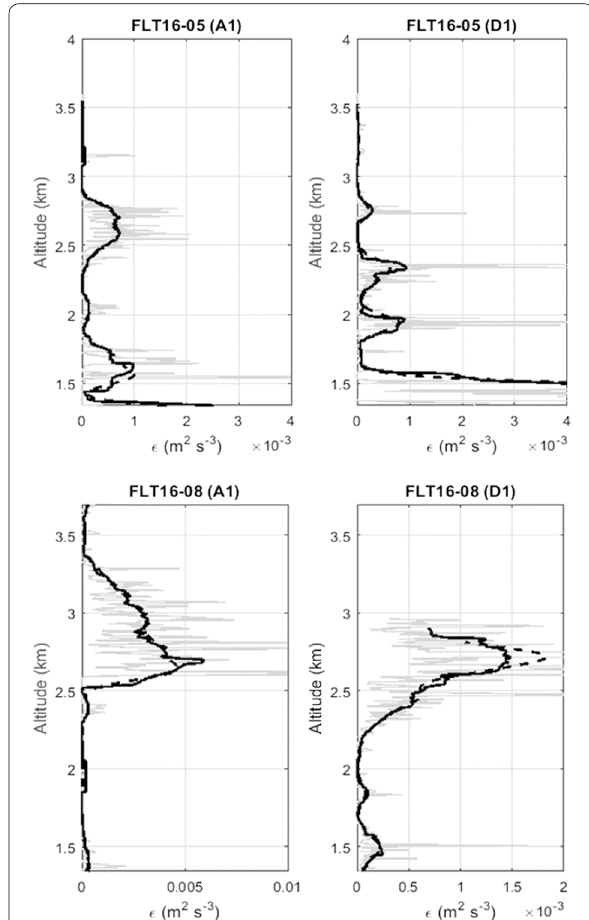
Fig. 6 Examples of the profiles of ε U for the first 2 ShUREX 2016 science flights (FLT16-05 and FLT16-08) during ascent (A1) and descent (D1). The thick solid and dashed black lines show smoothed profiles with a 30-point running rectangle window and a Gaussian weighting function consistent with the MU radar range weighting function (see